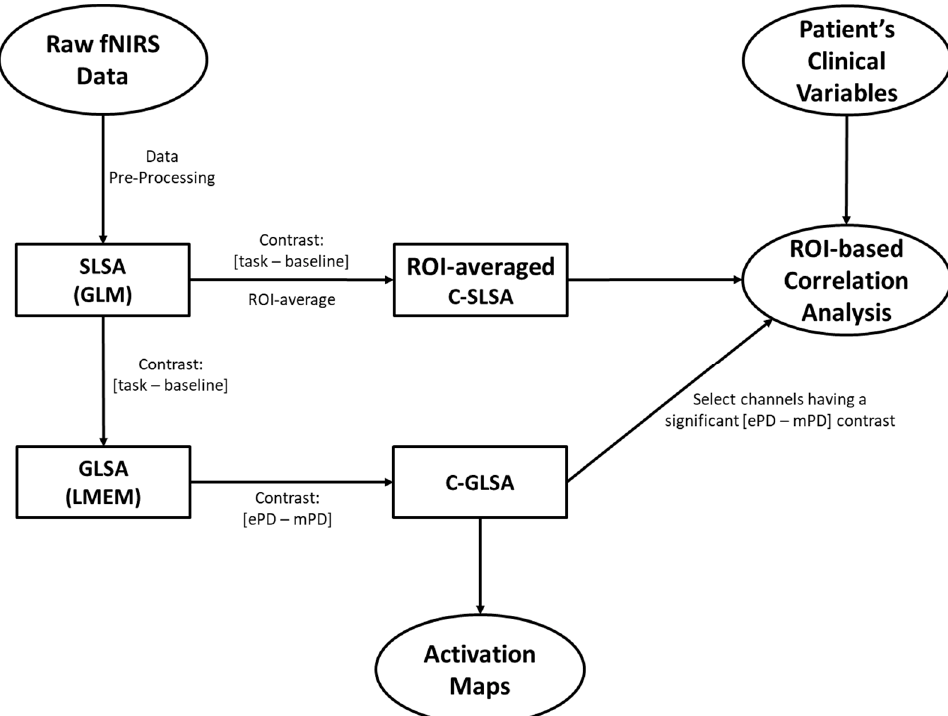
Figure 4. Conceptual framework of the main steps to obtain the ePD and mPD activation maps and perform ROI-based correlation analysis: subject-level statistical analysis (SLSA); group-level statistical analysis (GLSA); contrasted subject-level statistical analysis (C-SLSA); contrasted group-level statistical analysis (C-GLSA); general linear model (GLM); linear mixed effects model (LMEM).